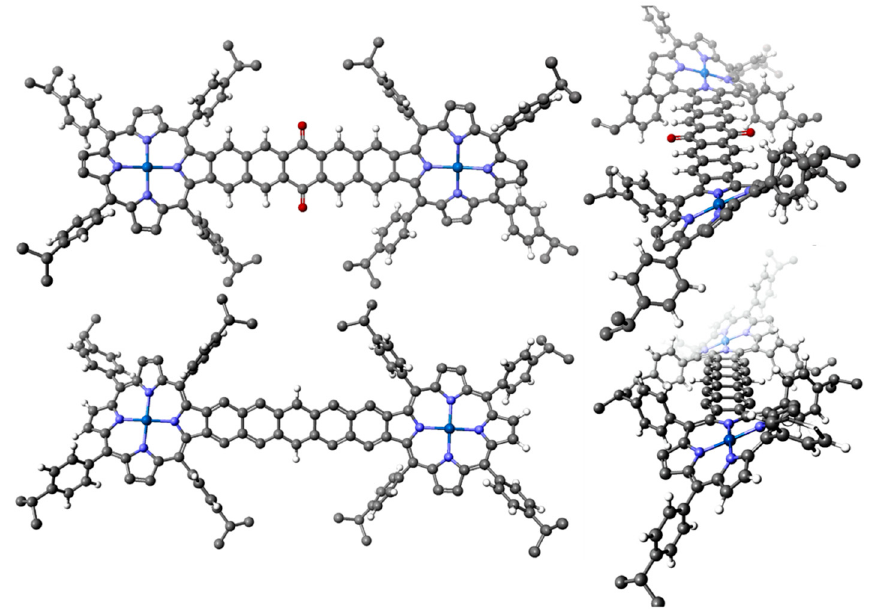
Figure 14. Molecular structures of the two fused-linker Ni-diporphyrins as calculated by density functional theory (DFT) optimization. ( Top ) Cross-conjugated quinone-linked dinaphtho[2,3]Zn-porphyrin (2a); ( Bottom ) Rigid conjugated pentacene peripherally-fused linked di-Ni-porphyrin (1a). Reproduced with permission, Jiang et al. [102].